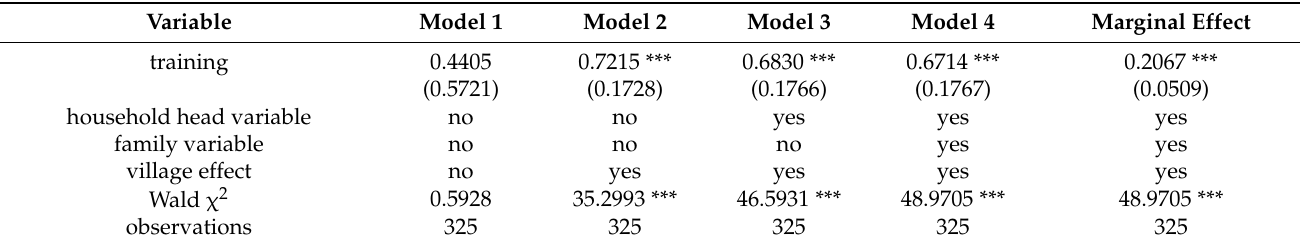
Table 4. Results of robustness test.